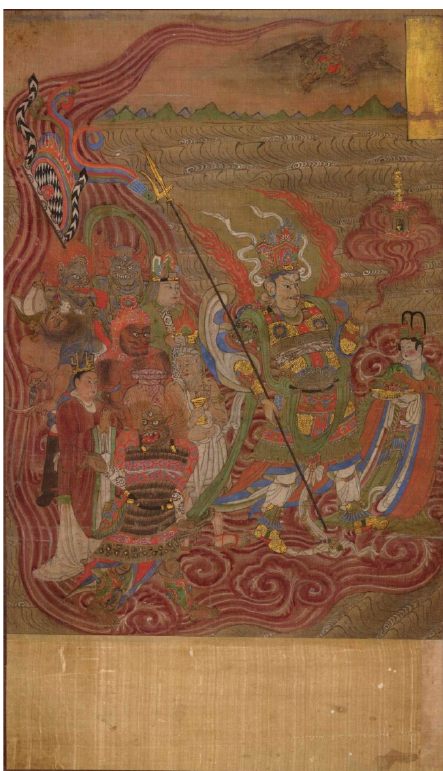
Figure 13. Guanyin attended by Two Donors . Dunhuang, c. 9th century. Banner; ink and color on silk, 95.3 × 61.8 cm. Harvard Art Museums/Arthur M. Sackler Museum, Second Fogg Expedition to China Fund (1925,12). Photo © President and Fellows of Harvard College. Religions 2020 , 11 , x FOR PEER REVIEW